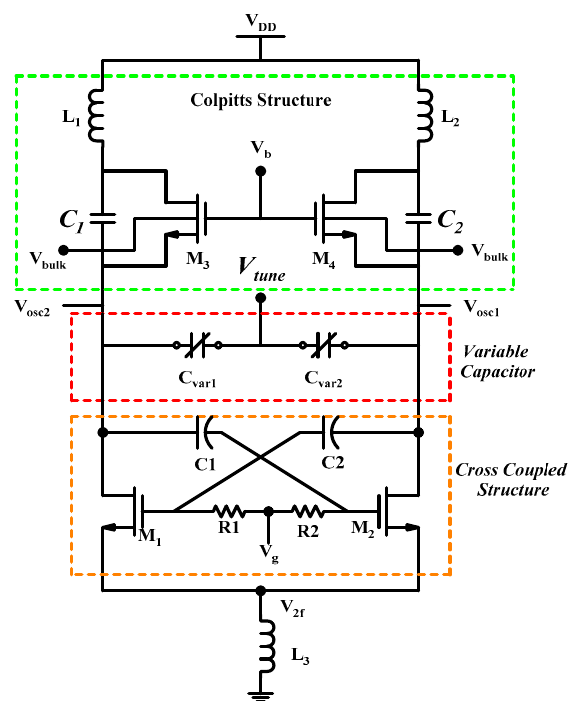
Figure 3. Proposed voltage controlled oscillator with combination of the Colpitts and cross-coupled structures.